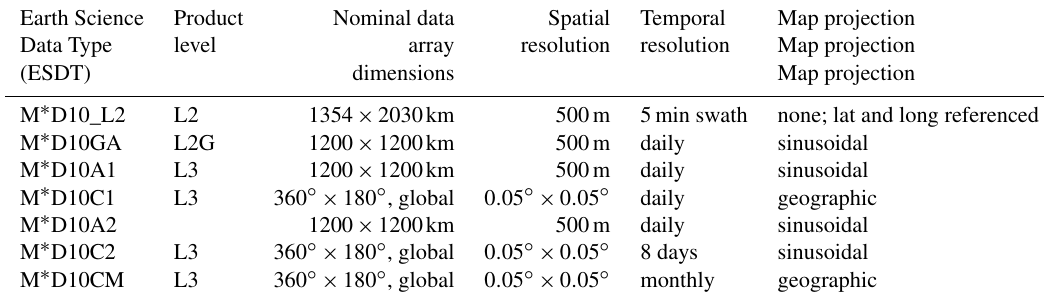
Table 1. MODIS Terra and Aqua snow data products, Terra (MOD) and Aqua (MYD) products are indicted by M ∗ D.